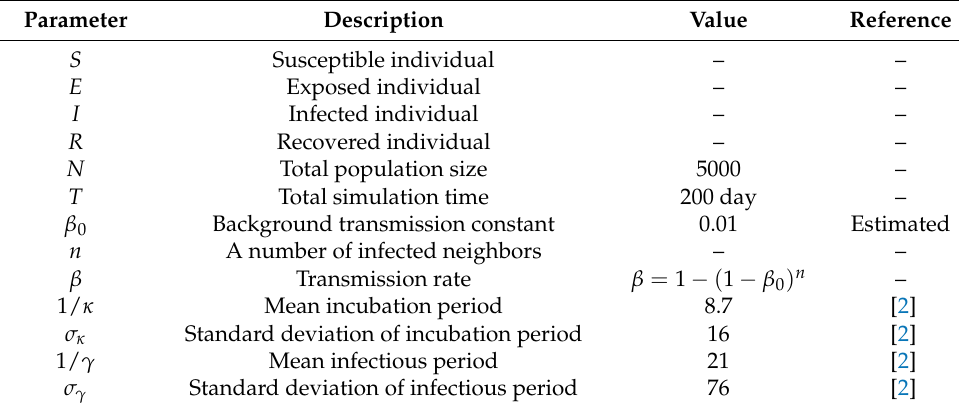
Table 1. Variables and baseline parameter values. Parameter Description Value